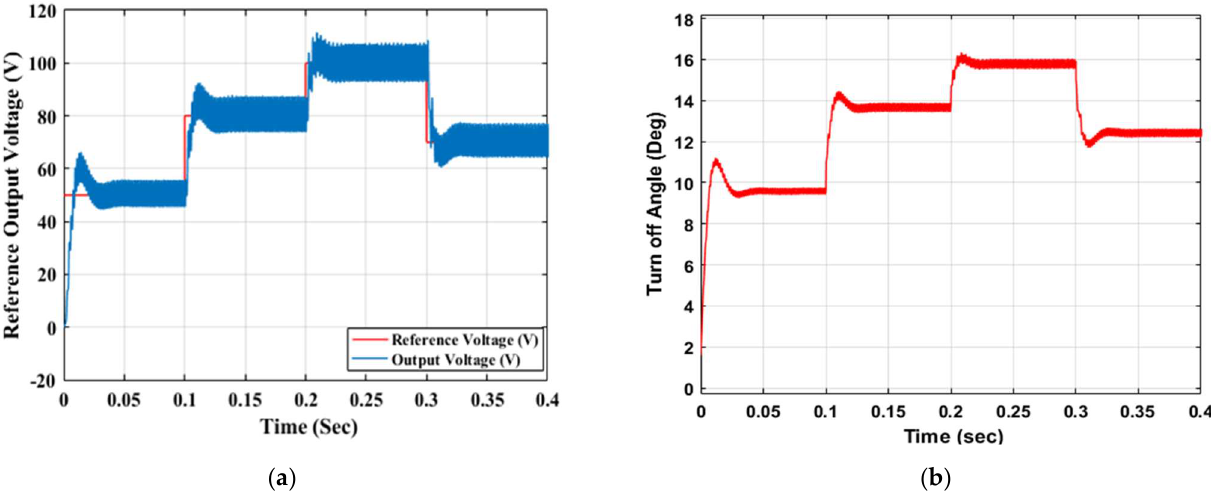
Figure 8. The transient response of turn-off angle control, ( a ) different reference output voltage (v); ( b ) the corresponding generated turn-off angle in deg.